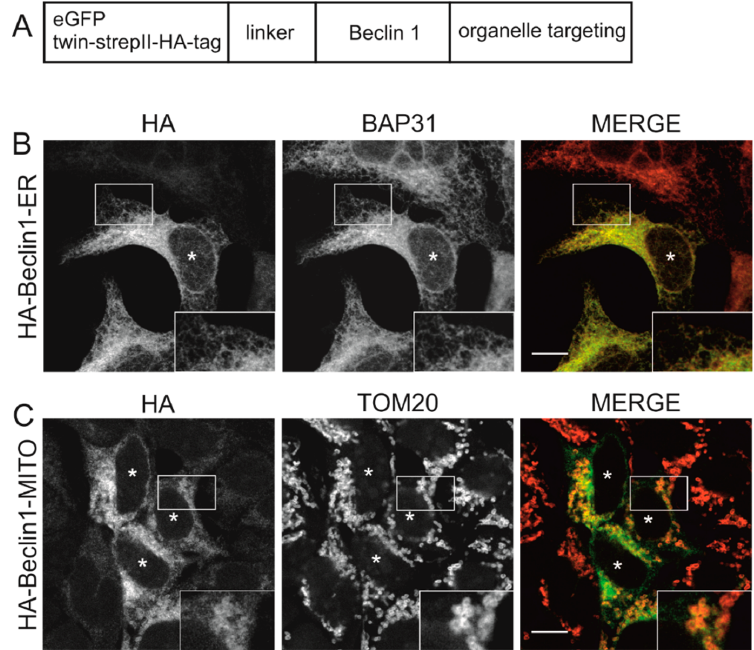
Figure 1. Subcellular localization of Beclin 1 targeted to endoplasmic reticulum and Beclin 1 targeted to mitochondria in HEK293 cells stably expressing the Twin-StrepII-HA-tagged Beclin 1 constructs. ( A ) Schematic representation of N-terminally epitope-tagged Beclin 1 constructs with C-terminal targeting peptides. ( B,C ) HEK293 cells stably expressing Twin-StrepII-HA-tagged Beclin 1-ER